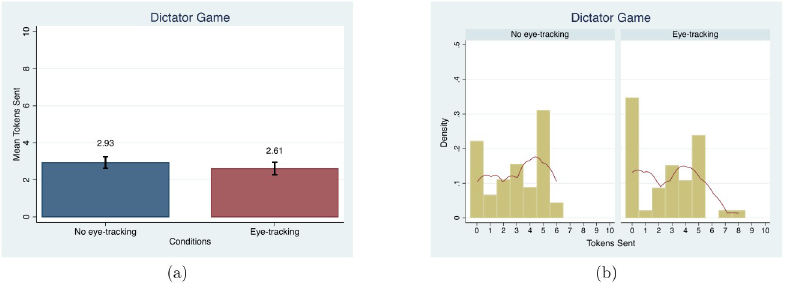
Fig 2. Mean and distribution comparisons in the number of tokens sent. Note. Red lines in (b) present the univariate kernel density estimation.